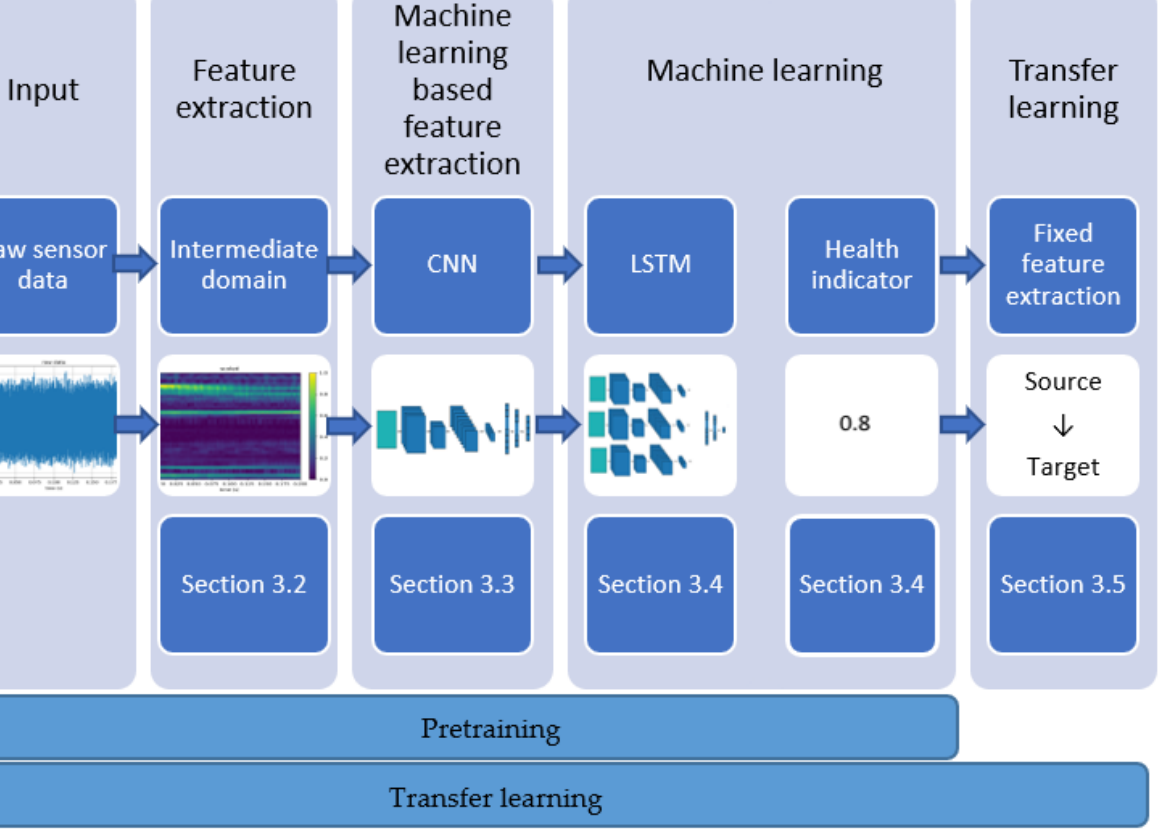
Figure 2. The different stages of the presented transfer learning-based RUL approach. This process is used for the transfer learning step but also for the pretraining of the network.